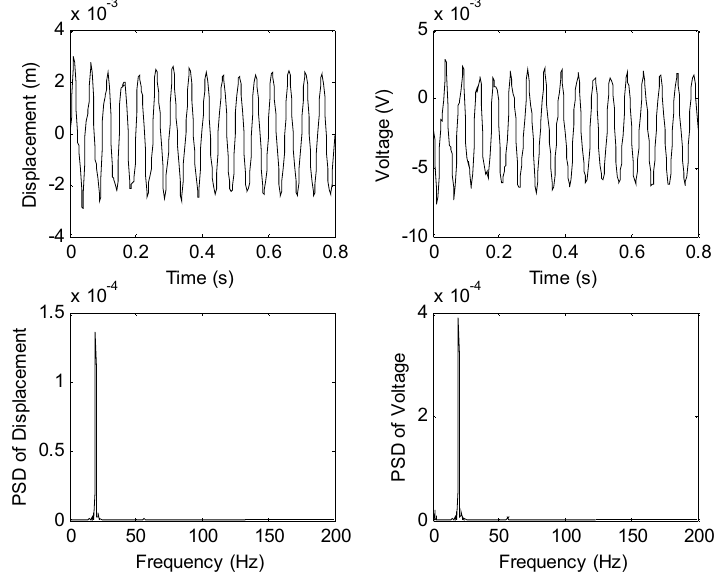
Fig. 20. Steady-state time history and frequency spectrum plots for vertical blade tip displacement and PZT sensor voltage at f = 20 Hz. A sinusoidal vertical step force of 20 Hz is acting at the tip of the blade where PZT sensor is mounted.